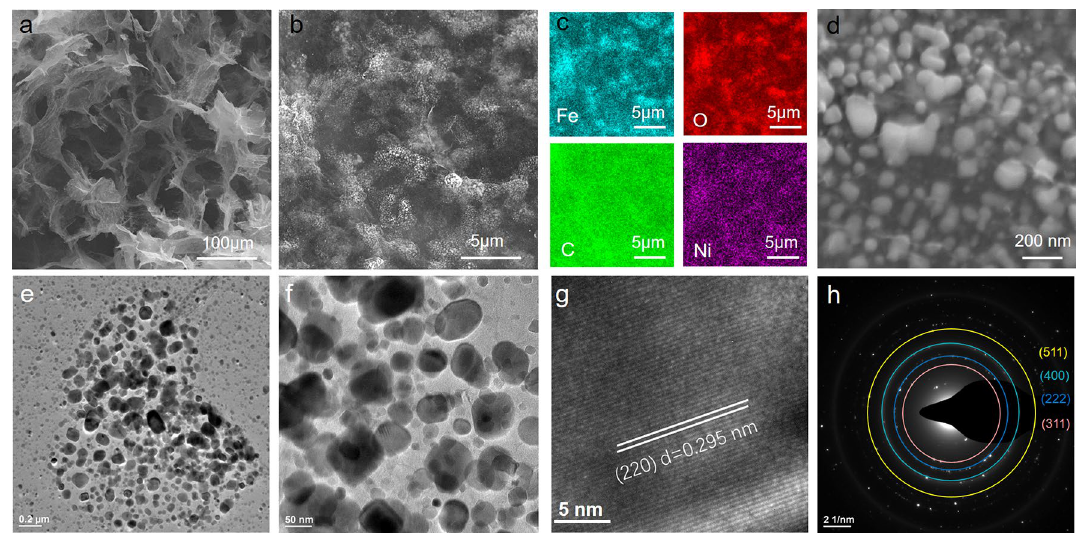
Fig. 4 a, b, d SEM, c elemental mapping (Fe, O, C, and Ni), e, f TEM, g HRTEM, and h SEAD images for f of the Ni-doped Fe 3 O 4 @C/rGO